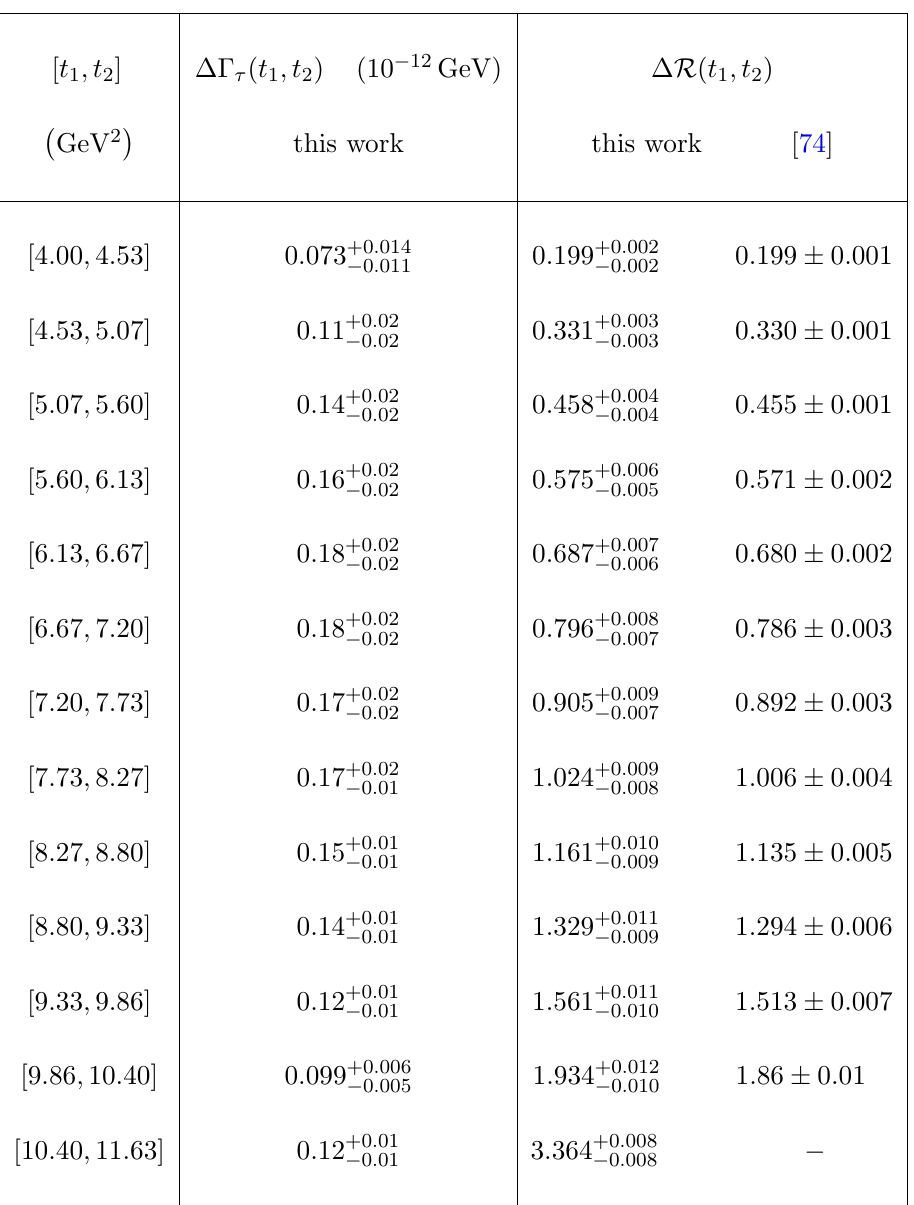
Table 3 . Theory predictions for the partial decay rates of B ! D(cid:28)(cid:23) (cid:28) and for the binned distribu- experimental data with the Boyd-Grinstein-Lebed parametrization [66] are employed for the recent calculations presented in